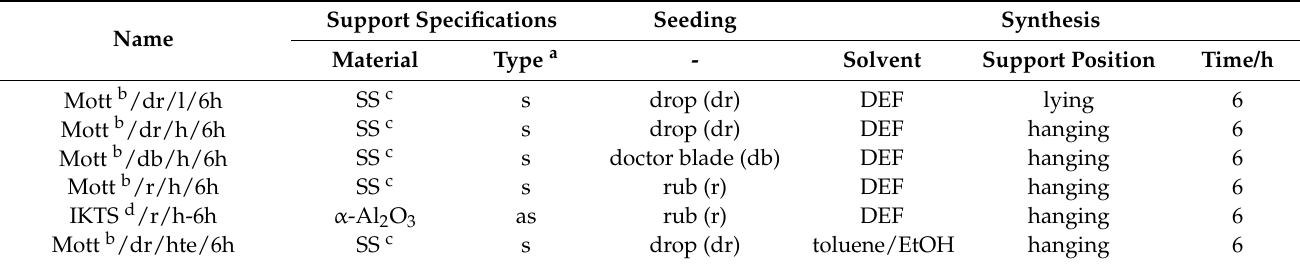
Table 4. Overview on the ZIF-11 membranes prepared by seeding and secondary